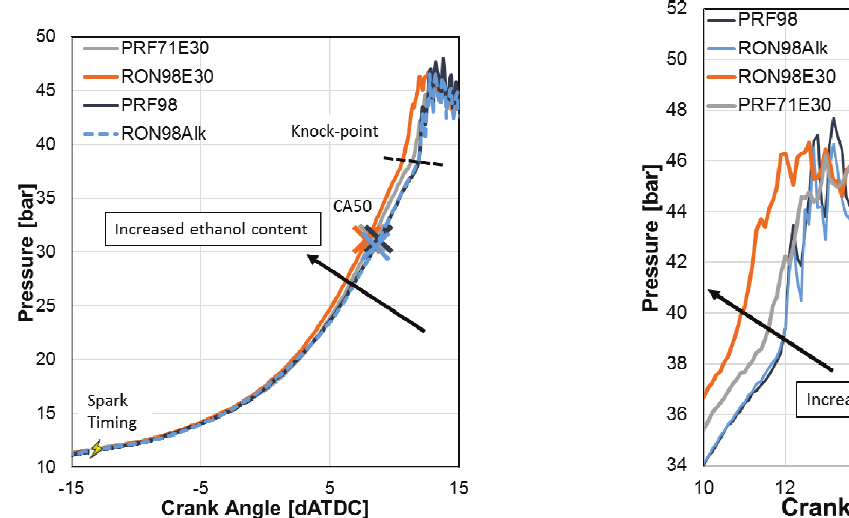
Fig. 10. Closer examination of the cylinder pressure behavior just after the knock-point